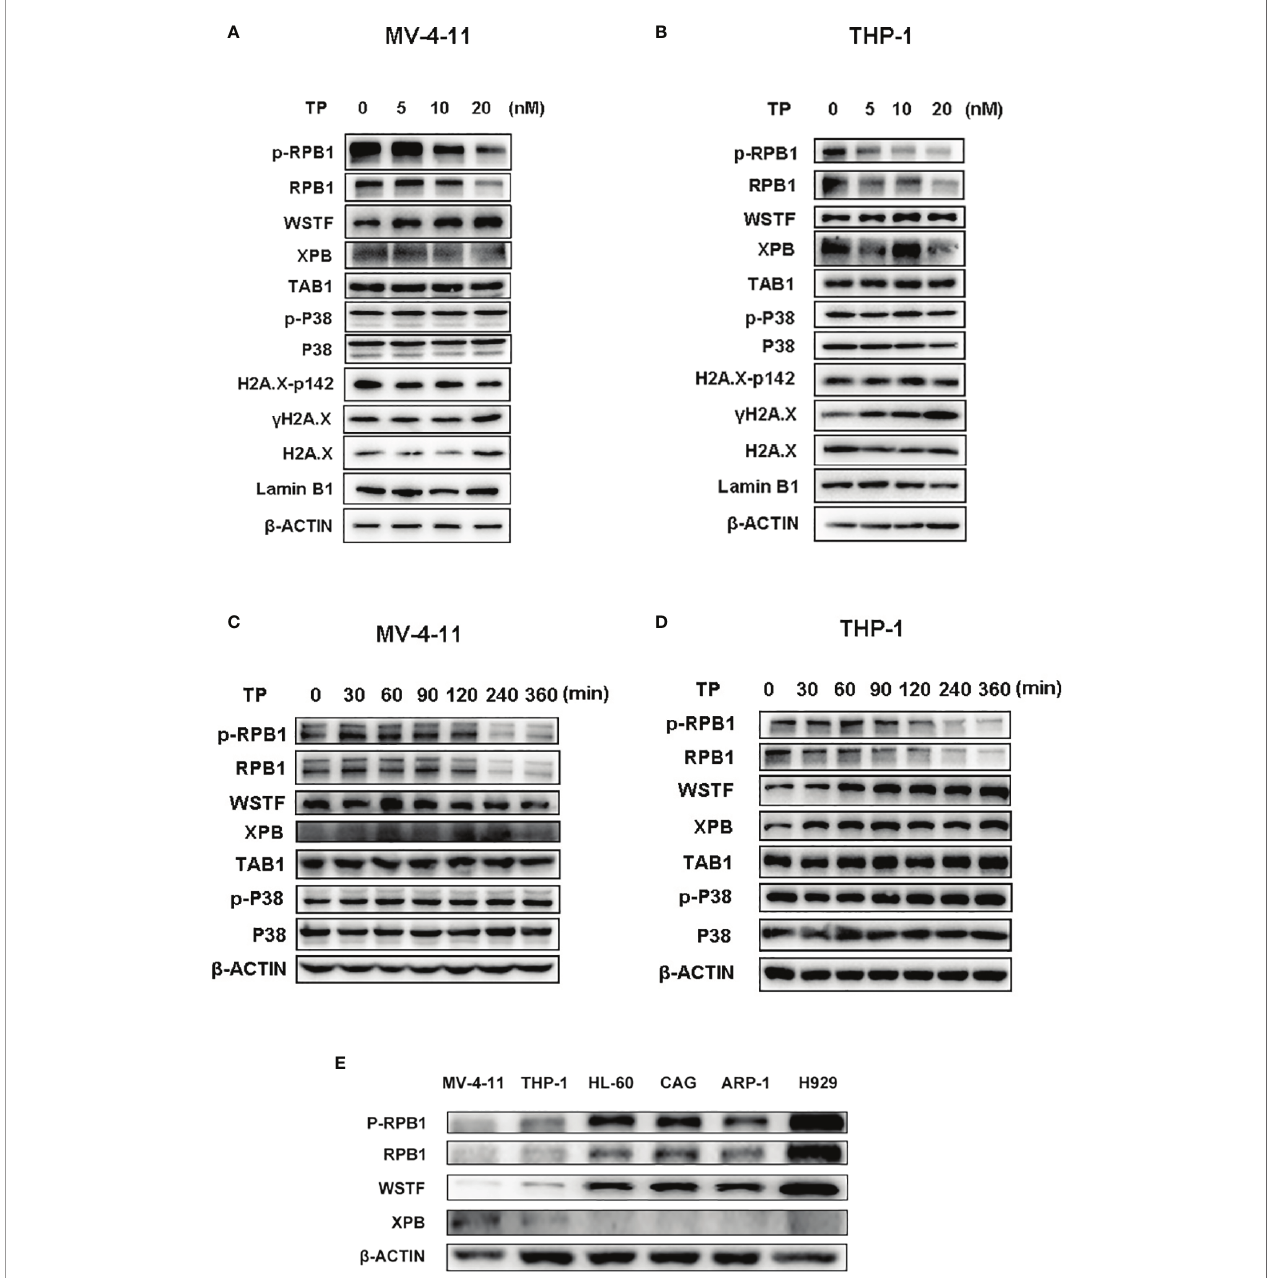
FIGURE 6 | WSTF-RPB1 is strongly associated with the anti-AML activity. Triptolide downregulates the WSTF and RPB1 signaling pathway without affecting TAB1/ P38 signaling in a dose dependent manner in MV-4-11 (A) and THP-1 (B) . Time-dependent experiments show that triptolide inhibits the WSTF-RPB1 signaling pathway with no effect on TAB1/P38 signaling in MV-4-11 (C) and THP-1 (D) . (E) The different expression levels of WSTF, XPB, and RPB1 is